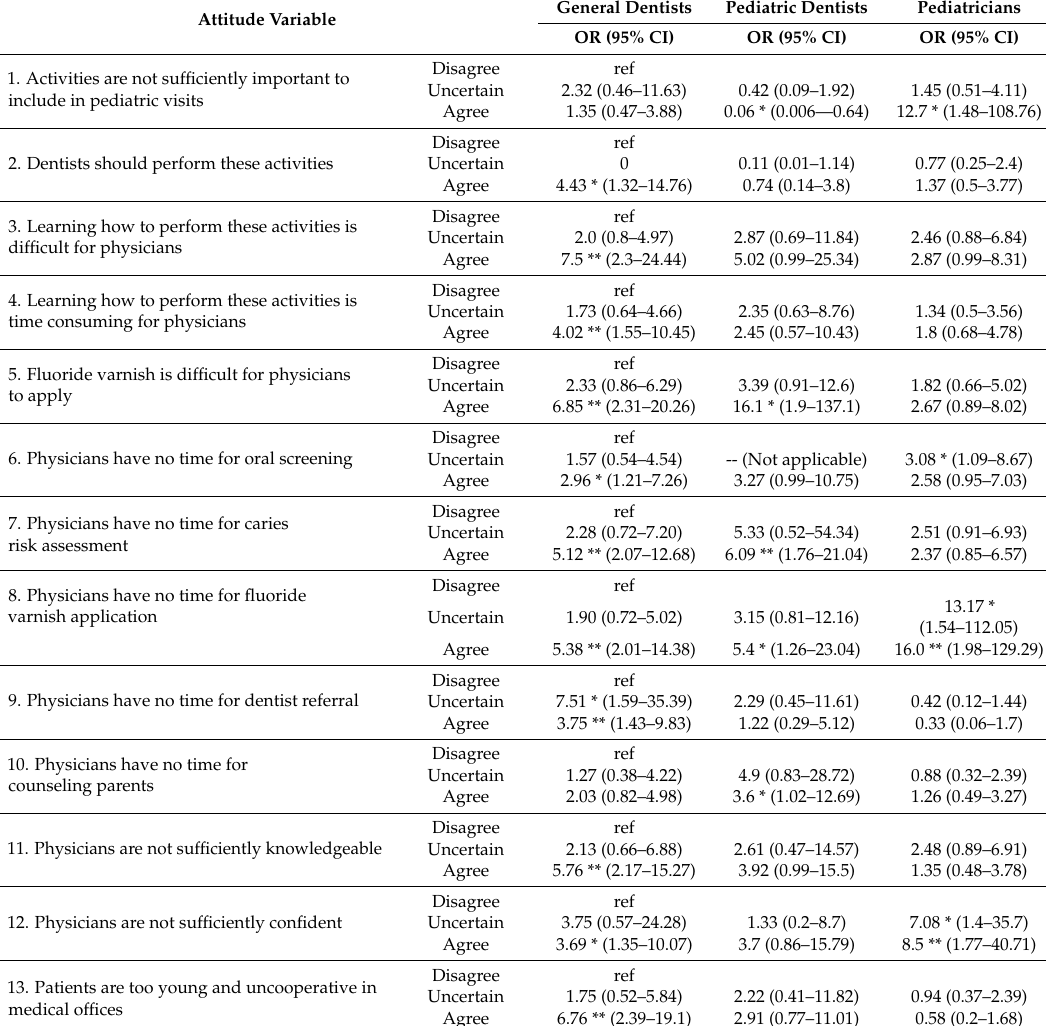
Table 6. Univariate logistic regression analysis on association of attitude items and disagreement on the statement “Do you agree that physicians can apply fluoride varnish to prevent Early Childhood Care (ECC) in